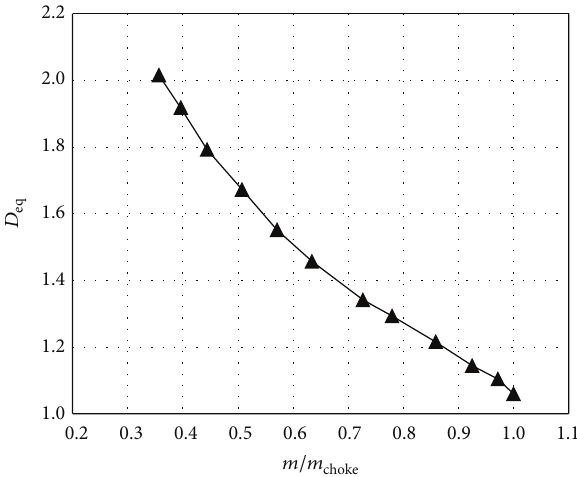
Figure 4: Equivalent diffusion